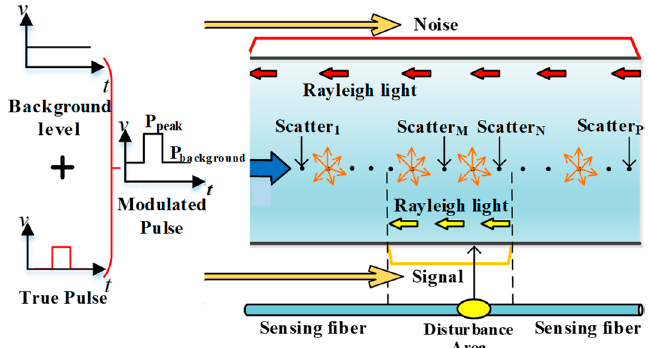
Figure 1. Theoretical model diagram of the influence of extinction ratio (ER) on signal-to-noise ratio (SNR).